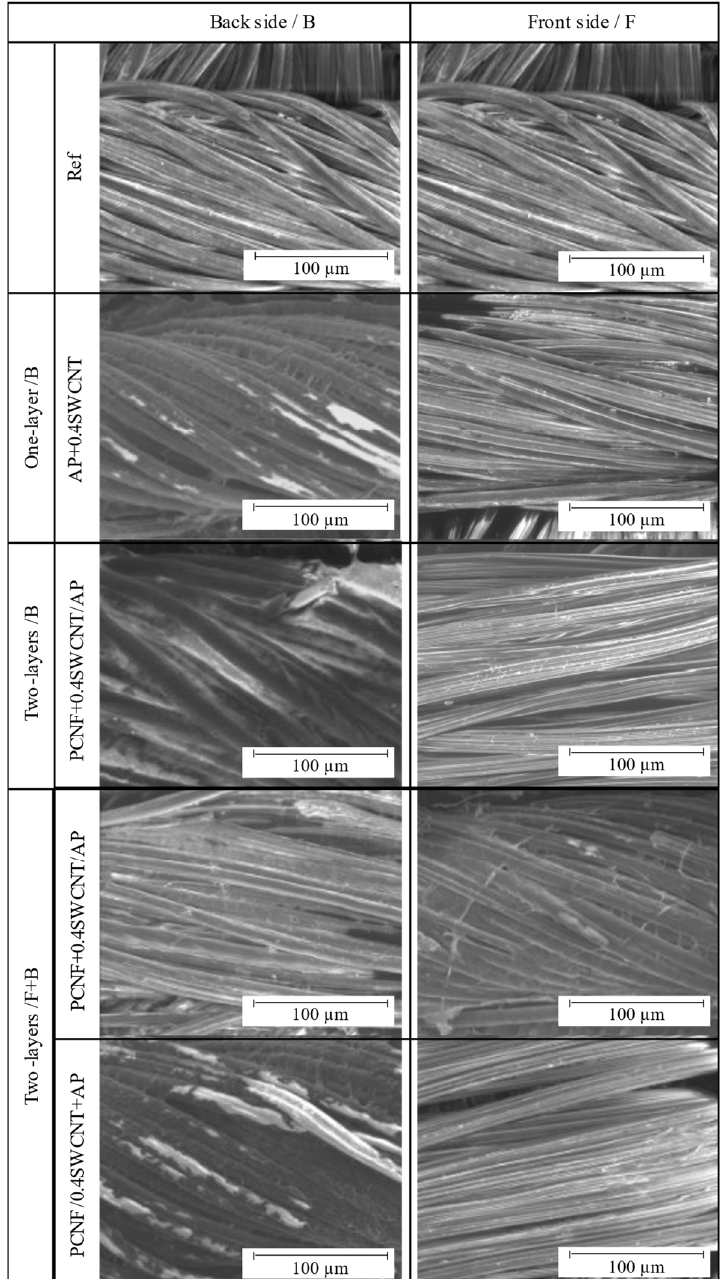
Figure 1. SEM images of the back/B and front/F sides of non-treated (Ref) and selected differently printed fabrics.